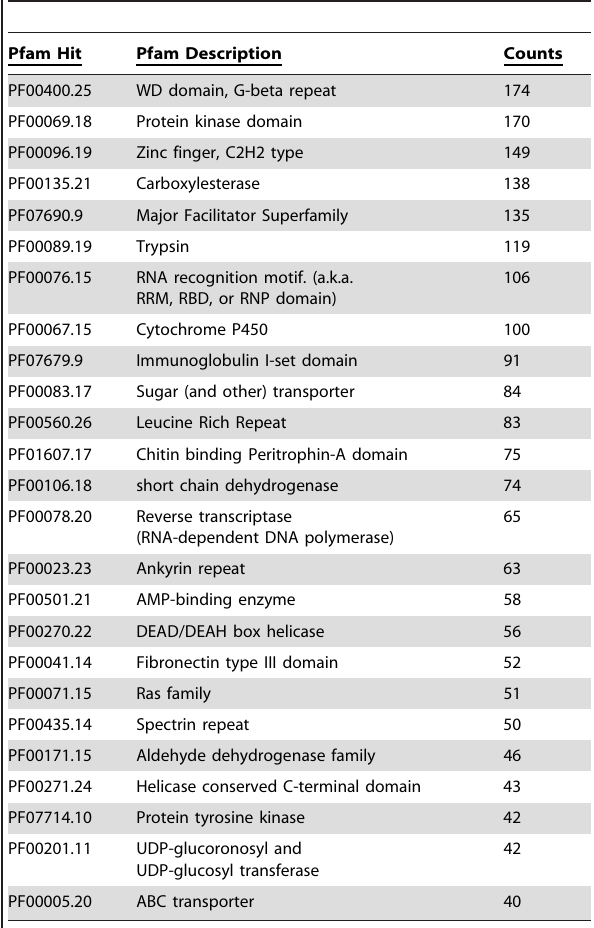
Table 1. The 25 most abundant Pfam families encountered in the complete gypsy moth PUT